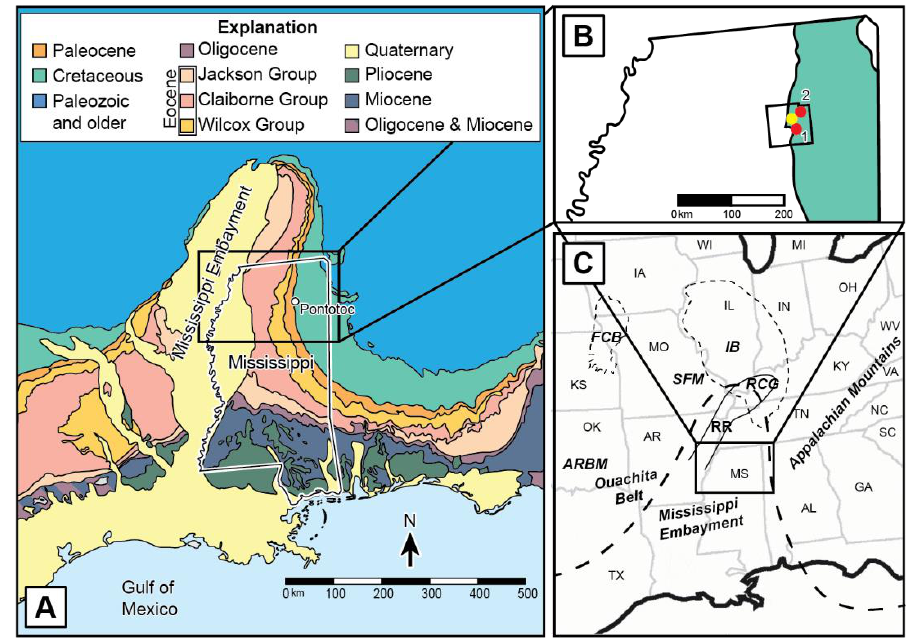
Figure 1. Cretaceous outcrops, basin locations, and structural maps of the Mississippi Embayment and central United States. ( A ) Mississippi Embayment outcrops with the location of Pontotoc County, MS (modified from Reed et al., [7]). ( B ) Locations of (1) southern sample location dots and (2) northern sample location are marked by red dots while the previously mined bentonite location is marked by a yellow dot. ( C ) Basin and structures of the central and eastern United States. ARBM — Arbuckle Mountains; FCB — Forest City Basin; IB — Illinois Basin; RCG — Rough Creek Graben; RR — Reelfoot Rift.